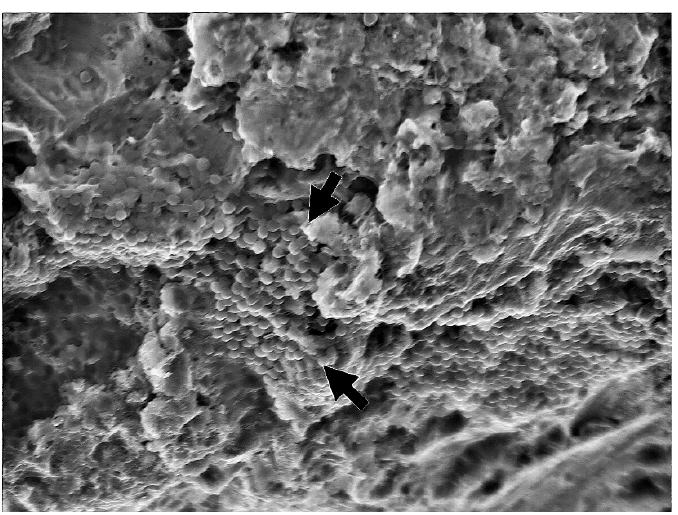
Figure 2. Biofilm formation confirmed using SEM (3000×)—arrows showing microorganism biofilm formation.